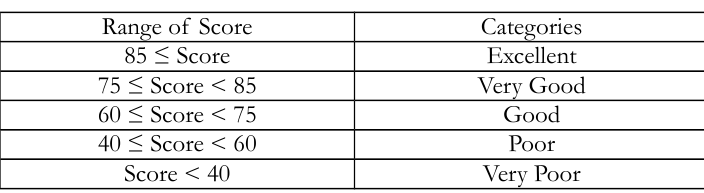
Table 2. Assessment criteria (Linn & Gronlund, 1995)